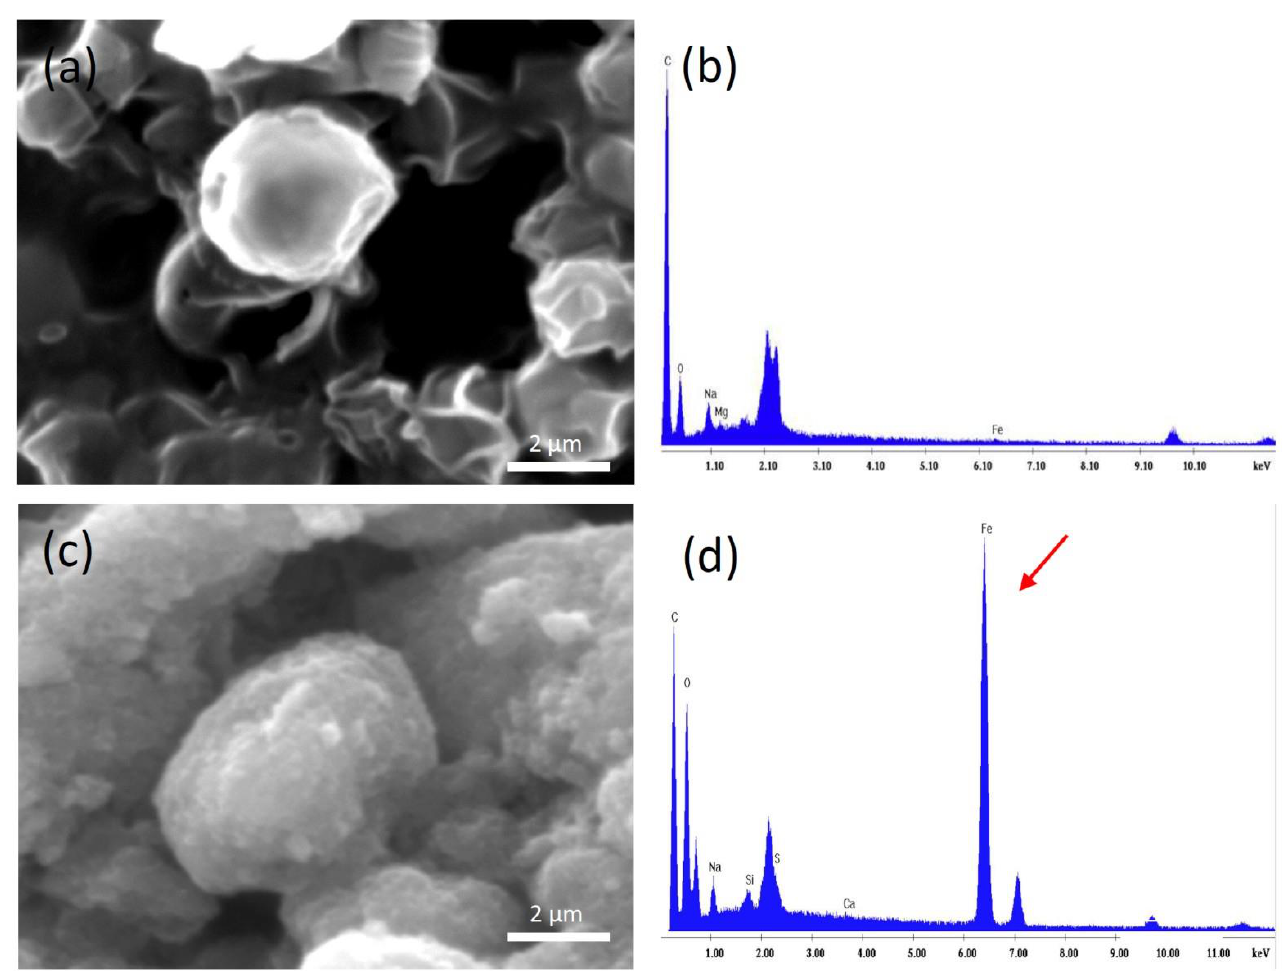
Figure 3. Scanning electron microscopy (SEM) images performed on ( a ) Chlorella vulgaris cells before magnetic harvesting, ( b ) EDX analysis for the elemental composition of the cells where the absence of iron peak is reported, ( c ) harvested Chlorella vulgaris cells at pH 3.0, ( d ) EDX analysis for the elemental composition of the harvested Chlorella vulgaris cells where the iron peak (arrow) is shown.